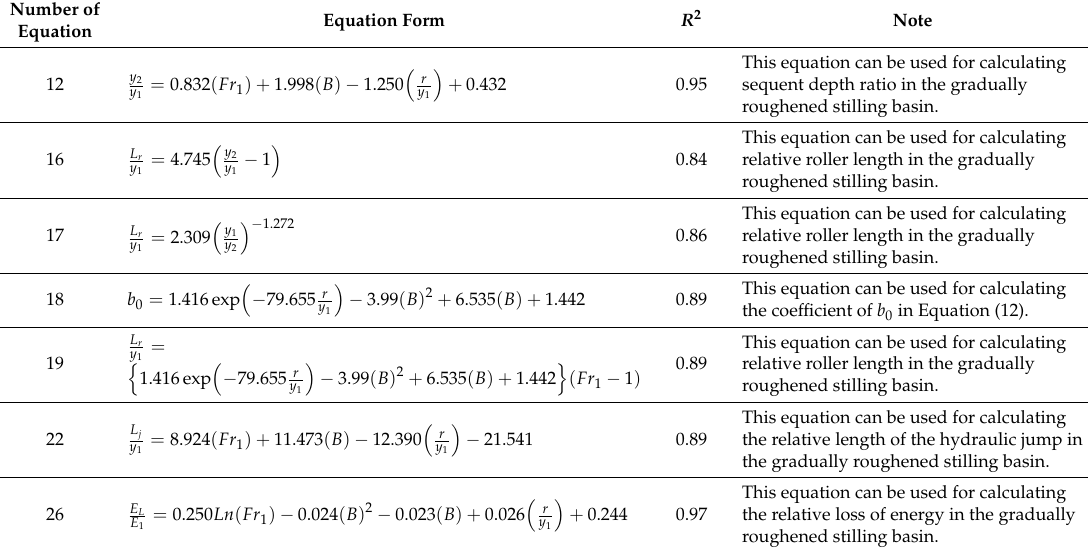
Table 5. Equations derived in this